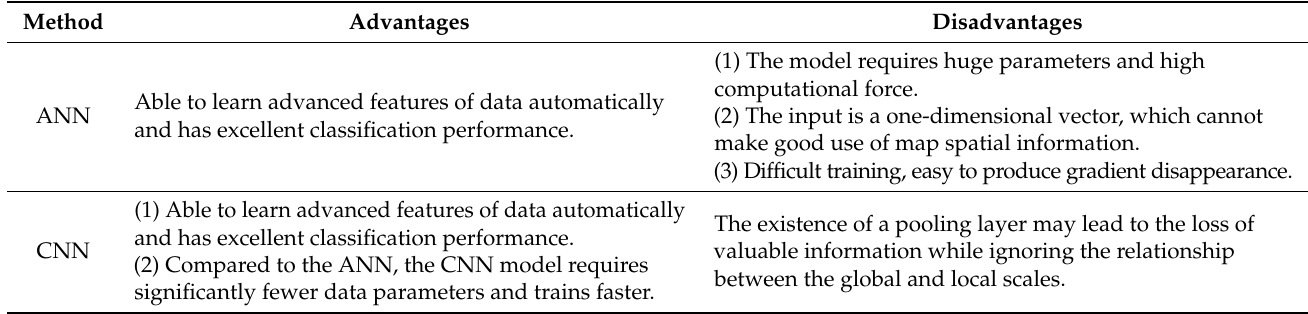
Table 4. Comparison of ANN and